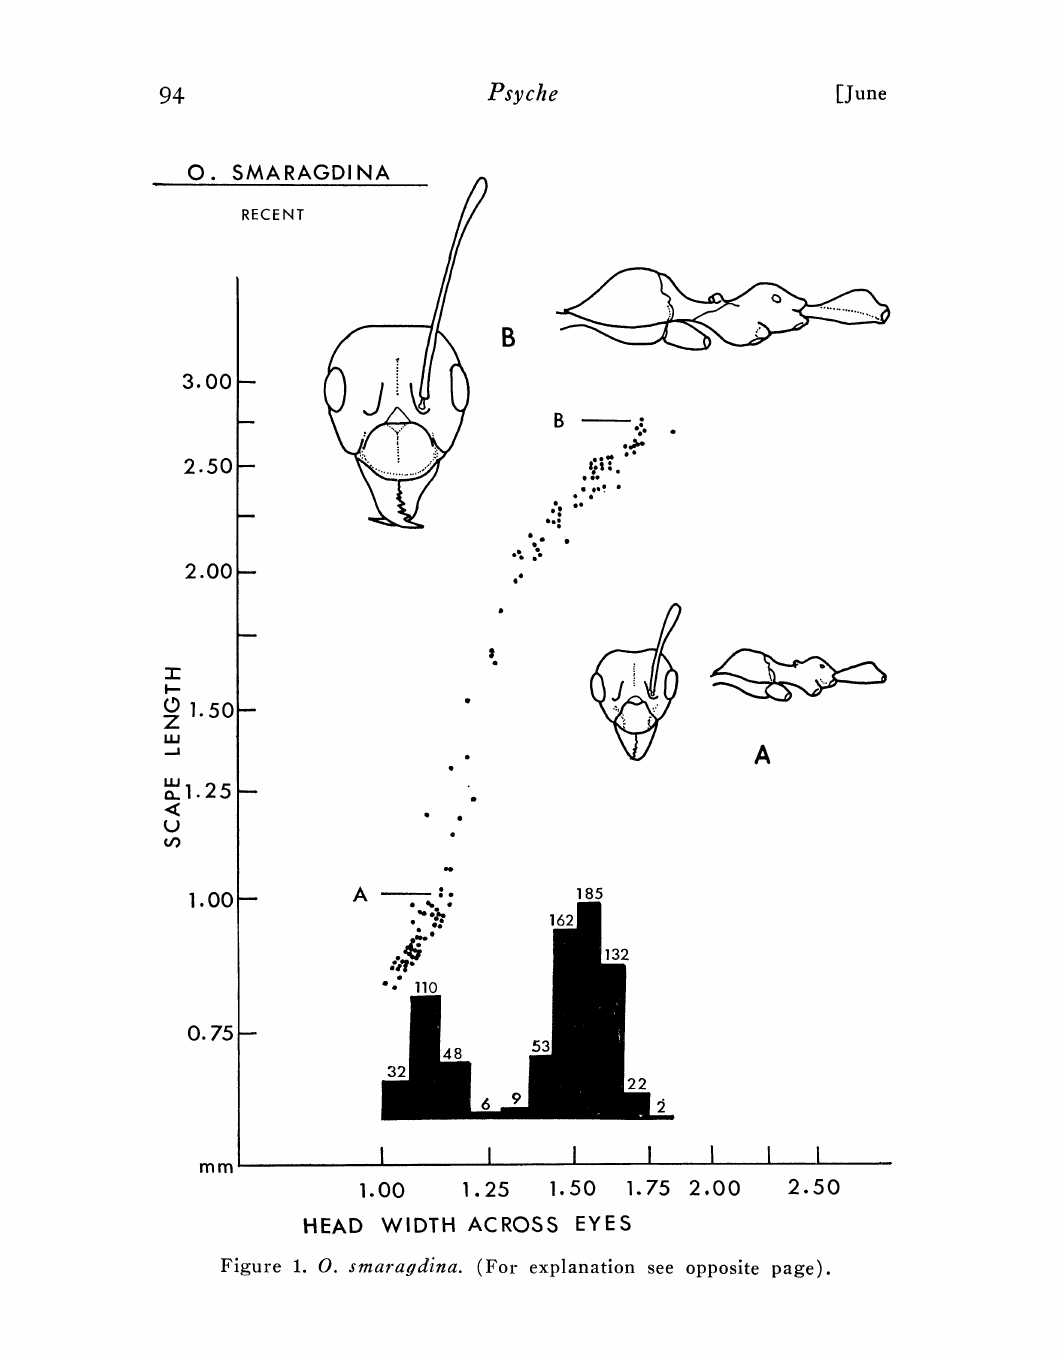
Figure 1. O. smaragd’ina. (For explanation see opposite